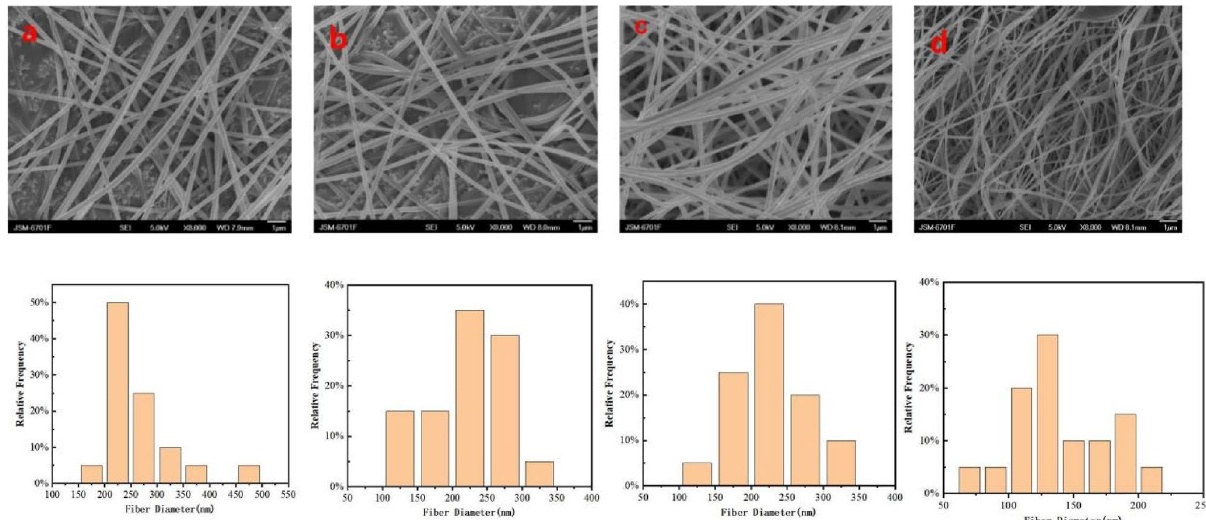
Figure 3. SEM images of electrospun CMKN fibers at different voltages and fiber diameters (( a ):15 kV; ( b ):18 kV; ( c ):21 kV; ( d ):25